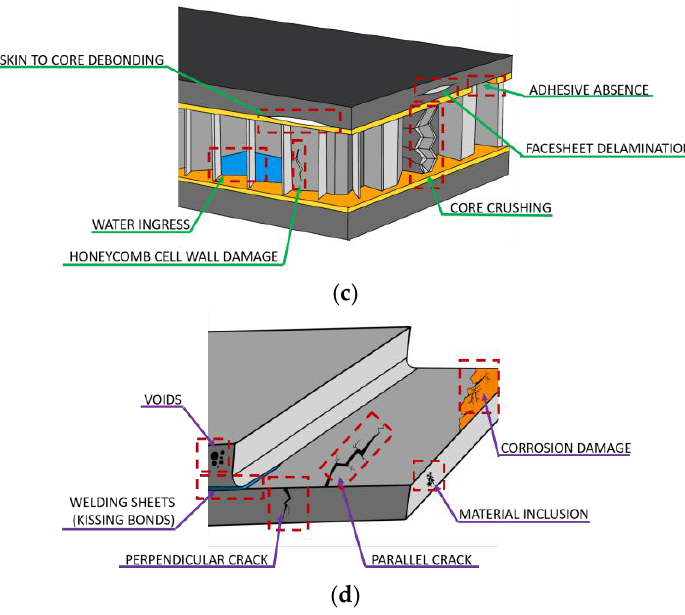
Figure 1 . Illustration of typical material defects monitored by IRT for composite aircraft and spacecraft structures ( a ); jet engine turbine blades ( b ); honeycomb panels ( c ) and metallic aircraft and spacecraft components ( d ).